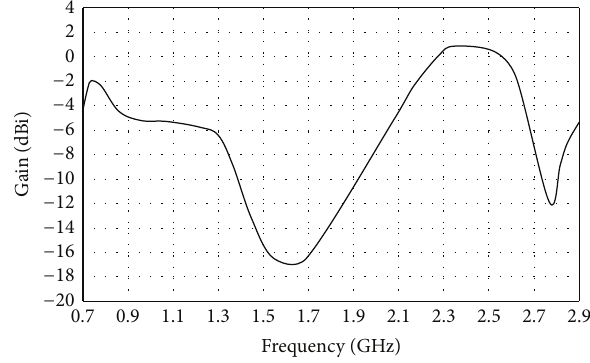
Figure 12: Total gain of the proposed